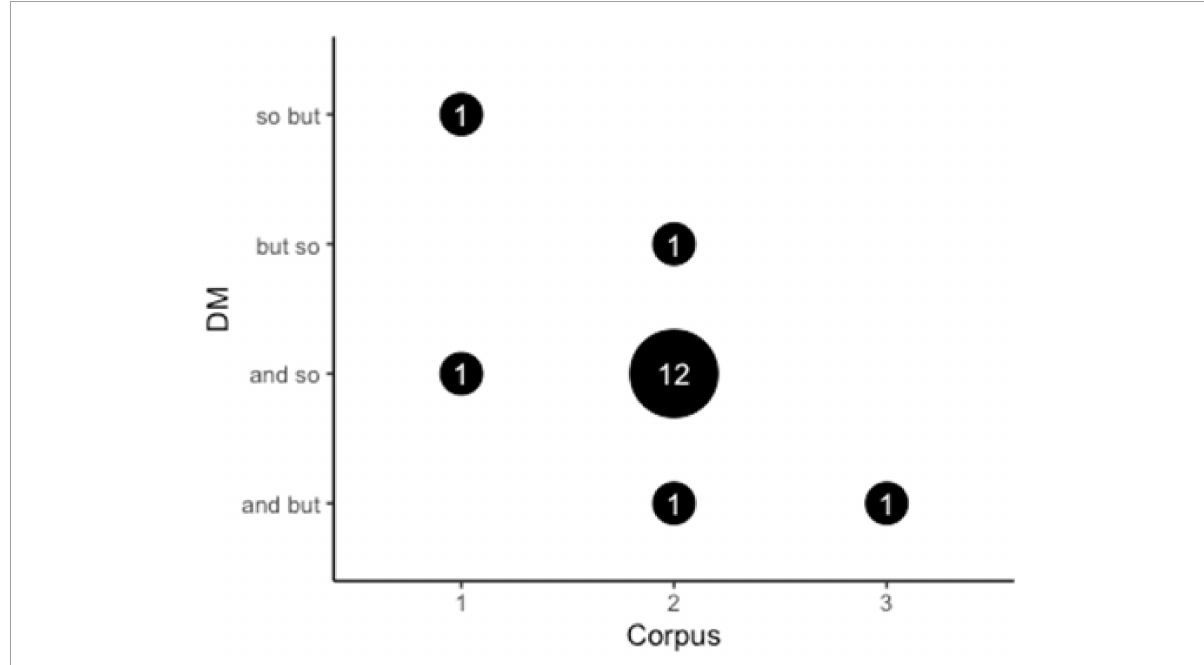
FIGURE5 The frequency of the co-occurrences of the three DMs in the three corpora. (1-the Chinese Corpus, 2-the US Corpus, 3-the UK Corpus).